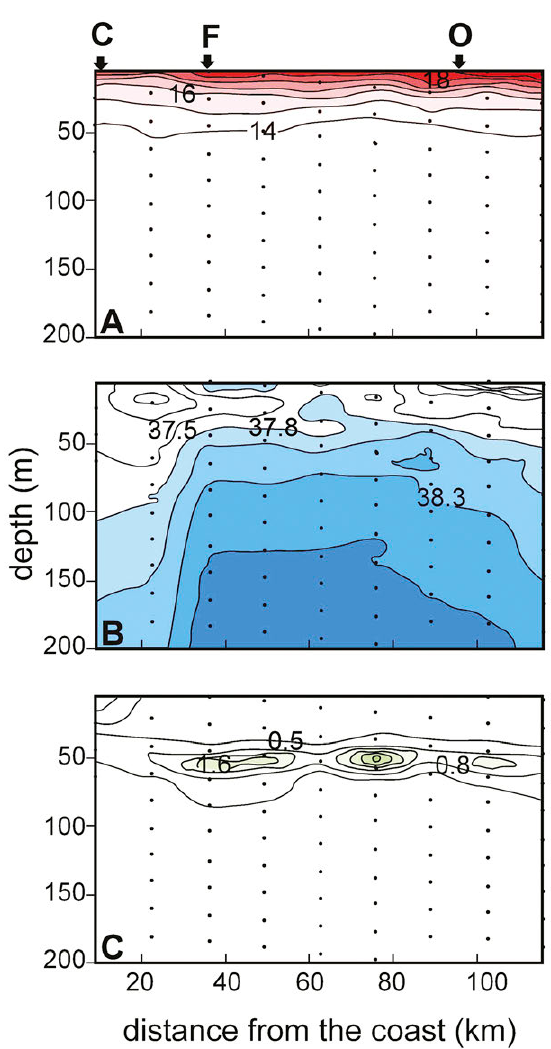
Fig. 2. – Distribution of temperature (A), salinity (B) and chlo- rophyll a (C) from 0 to 100 m depth along the transect between Barcelona and the Majorca-Menorca channel during the first study day (JD 153). In the horizontal axis, the distance to the coast refers to Barcelona.